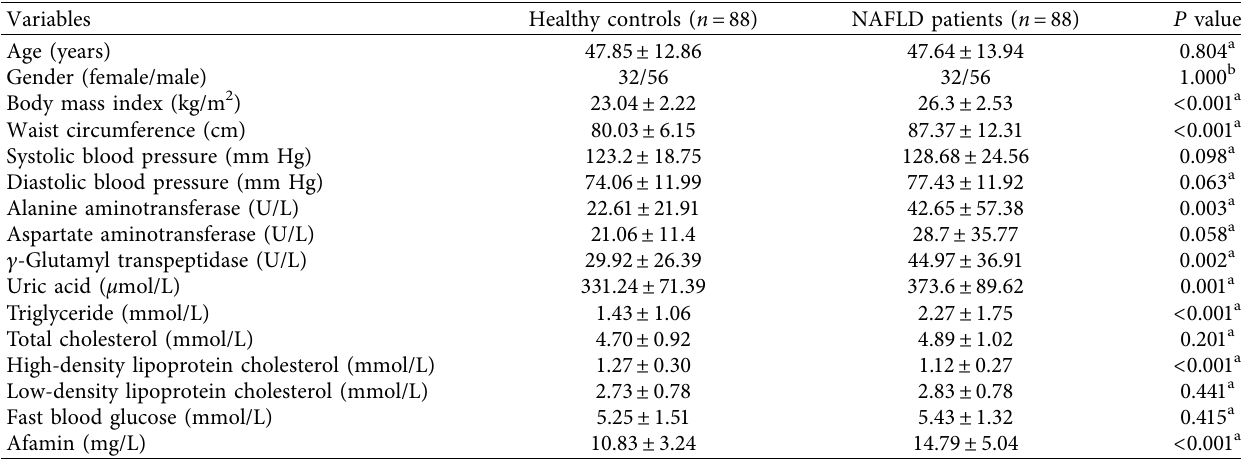
Table 1: Clinical characteristics of NAFLD patients and healthy controls.